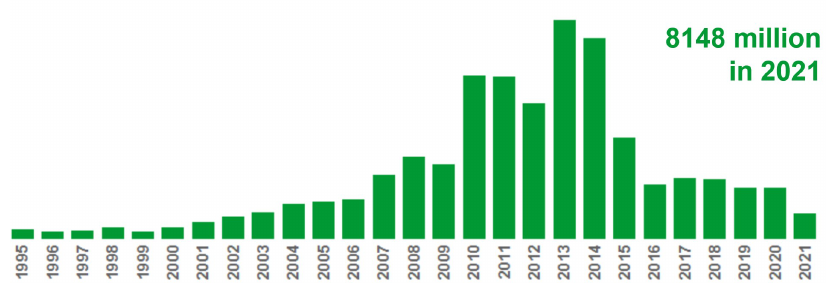
Figure 6. Investments made by BNDES in low-carbon products.